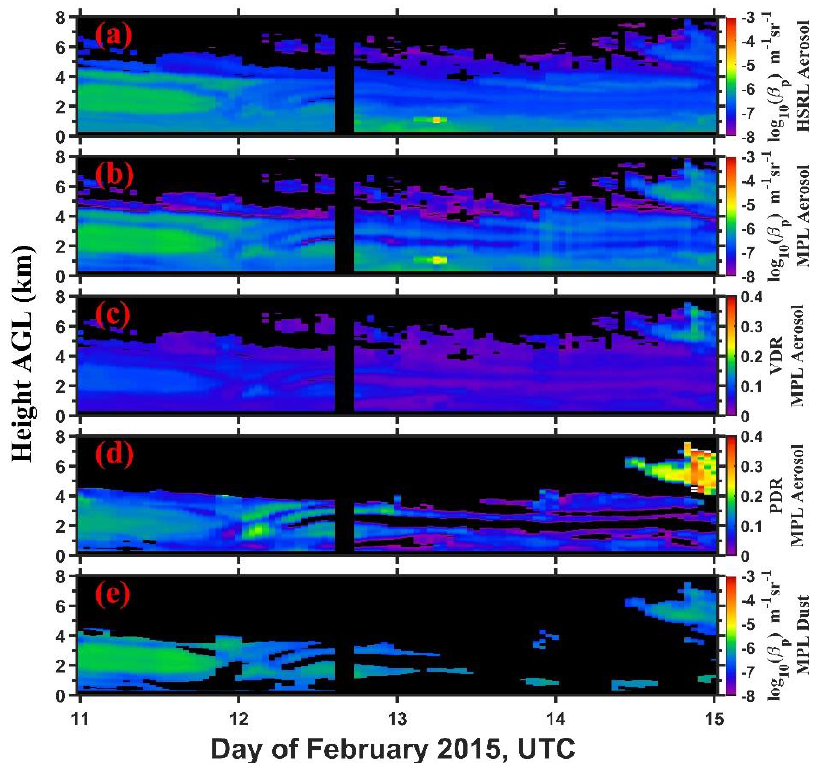
Figure 2. The time-height section of ( a ) HSRL particular backscatter coefficients, ( b ) MPL retrieved particular backscatter coefficients, ( c ) MPL total volume depolarization ratio (VDR), and ( d ) MPL particle depolarization ratio (PDR) from February 11 to 14, 2015 at the NSA site. ( a – d ) are for all aerosols. ( e ) MPL backscatter coefficient for dust aerosols that are identified using the PDR threshold 0.09.